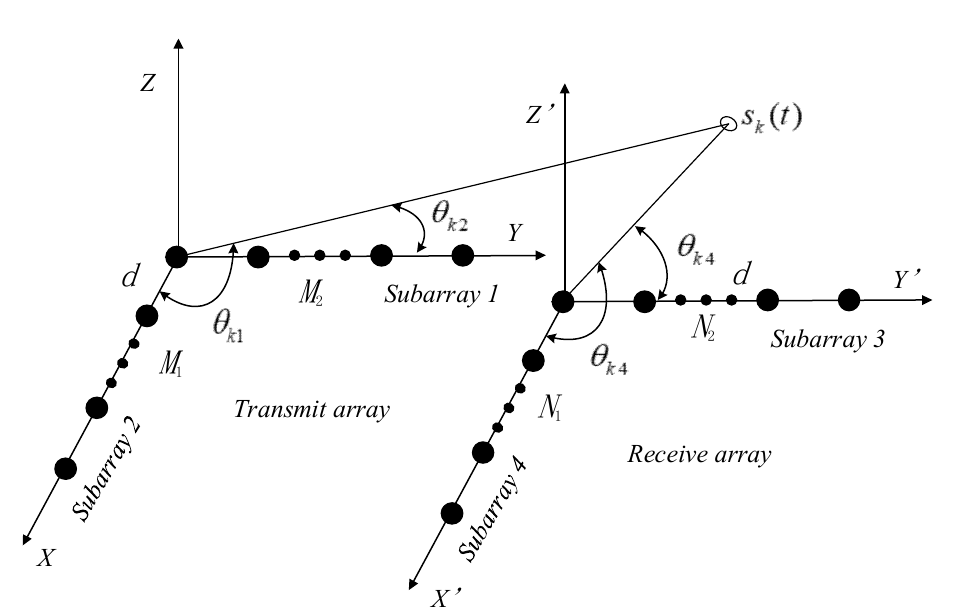
Figure 1. A diagram for the L-shaped multiple input multiple output (MIMO) array structure.